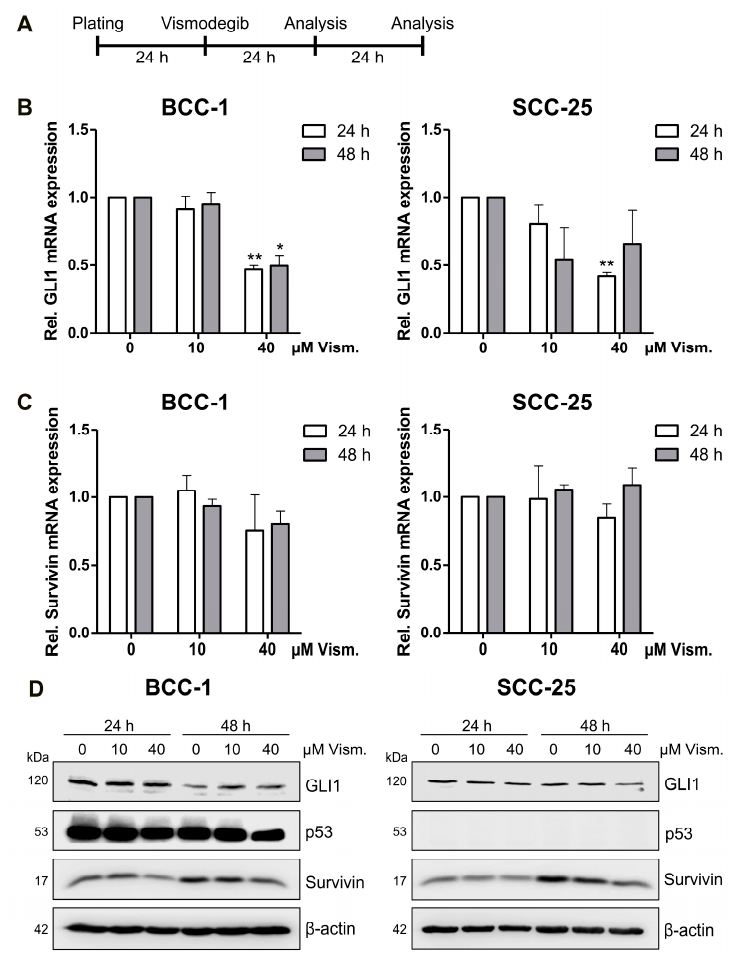
Figure 2. Vismodegib decreases hedgehog (Hh) target gene glioma-associated oncogene homologue 1 (GLI1) and Survivin expression. ( A ) Time schedule of vismodegib application and RNA/protein extraction for analysis. BCC-1 or SCC-25 cells were plated 24 h before treatment with 10 or 40 µM vismodegib or with DMSO as control for 24 h or 48 h before analysis. ( B ) mRNA expression for GLI1 and Survivin ( C ) relative to DMSO-treated controls. n = 2 (in duplicate); * p < 0.05, ** p < 0.01 (vismodegib- versus DMSO-treated cells, t -test). ( D ) Representative Western blots from at least two independent experiments, including detection of p53 expression in the cell lines. β -actin served as loading control. Rel., relative; Vism., vismodegib.